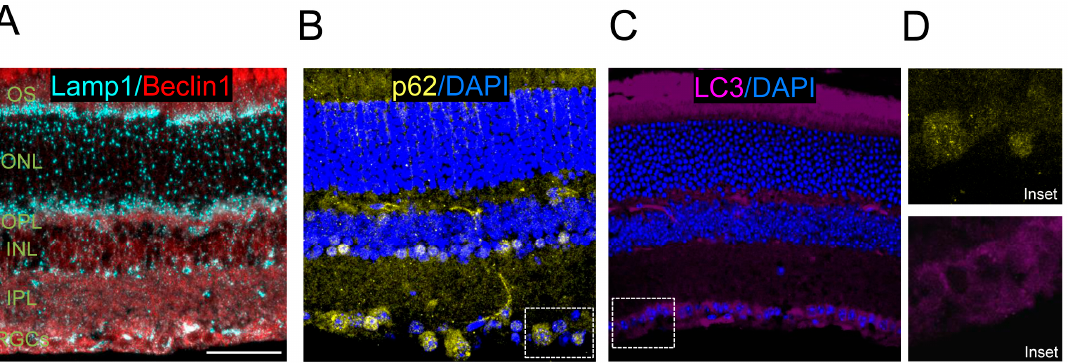
Figure 4. Immunolabelling of autophagy proteins in eye cryosections from wild type mouse. ( A ) Lysosomes are immunolabeled using antibodies against Lamp1 (1D4B Developmental Sudies Hibridoma Bank, in cyan) and the autophagy regulator Beclin 1 (SantaCruz Biotechnology sc-48381, in red); ( B ) p62 (Progen GP62-C) is labelled in yellow and retinal nuclei are labelled with DAPI (in blue); ( C ) endogenous LC3 staining (Nanotools, 5F10, in magenta) with DAPI nuclear labelling (in blue). Scale bar 20 µ m; and ( D ) insets for p62 and LC3 stainings.